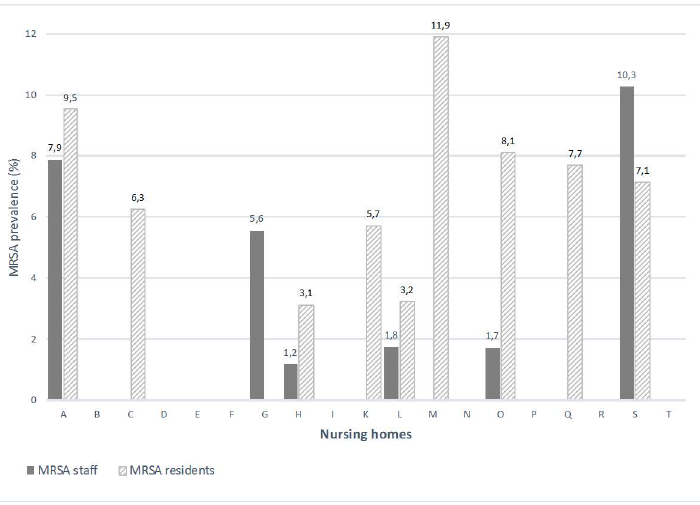
Fig 1. MRSA prevalencein 19 geriatric nursing homes in Hamburg. Prevalenceis given as a percentage of total staff/residents screenedand homes.